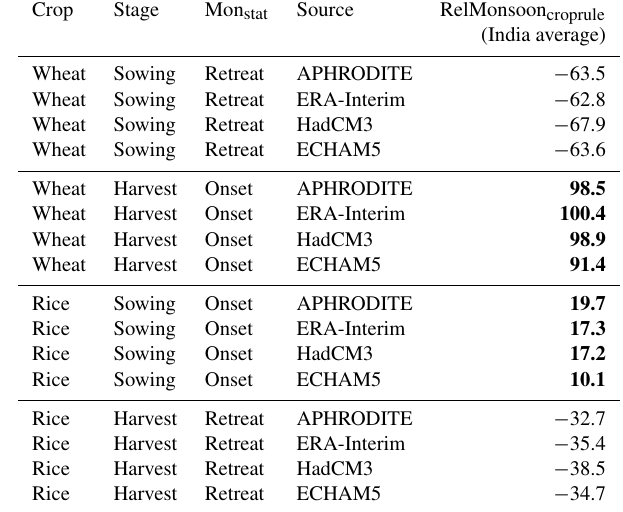
Table 1. Table of RelMonsoon croprule for each dataset, crop, and stage. The RelMonsoon croprule is the value subtracted from the monsoon onset and retreat in order to calculate a new sowing or har- vest date based on the monsoon onset and retreat. In each case the new estimate of the sowing and harvest dates is calculated by sub- tracting the RelMonsoon croprule from the Mon stat , where Mon stat is monsoon onset or monsoon retreat from HNRCM or APHRODITE precipitation observations. Where the sowing or harvest is before the monsoon statistic, the crop rule is in bold with normal type in- dicating that sowing or harvest occurs after the monsoon